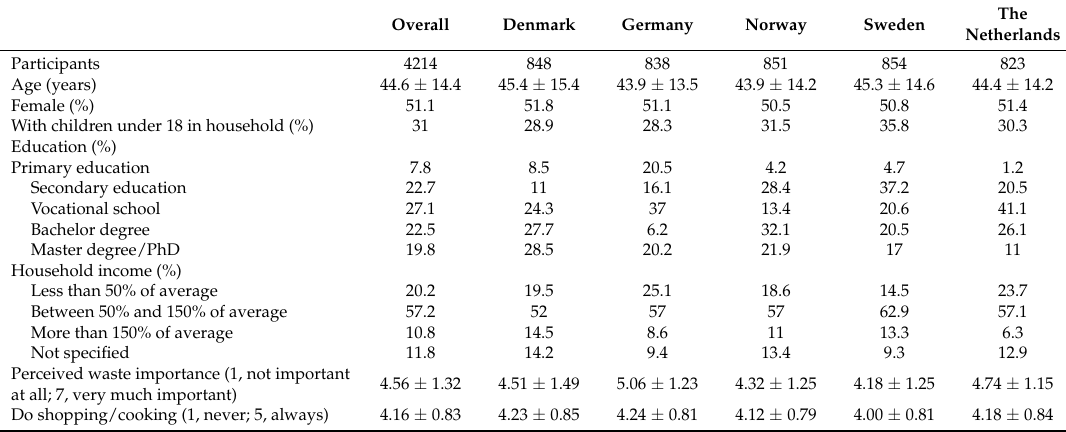
Table 1. Sociodemographic description of the participants of the online survey. Overall Denmark